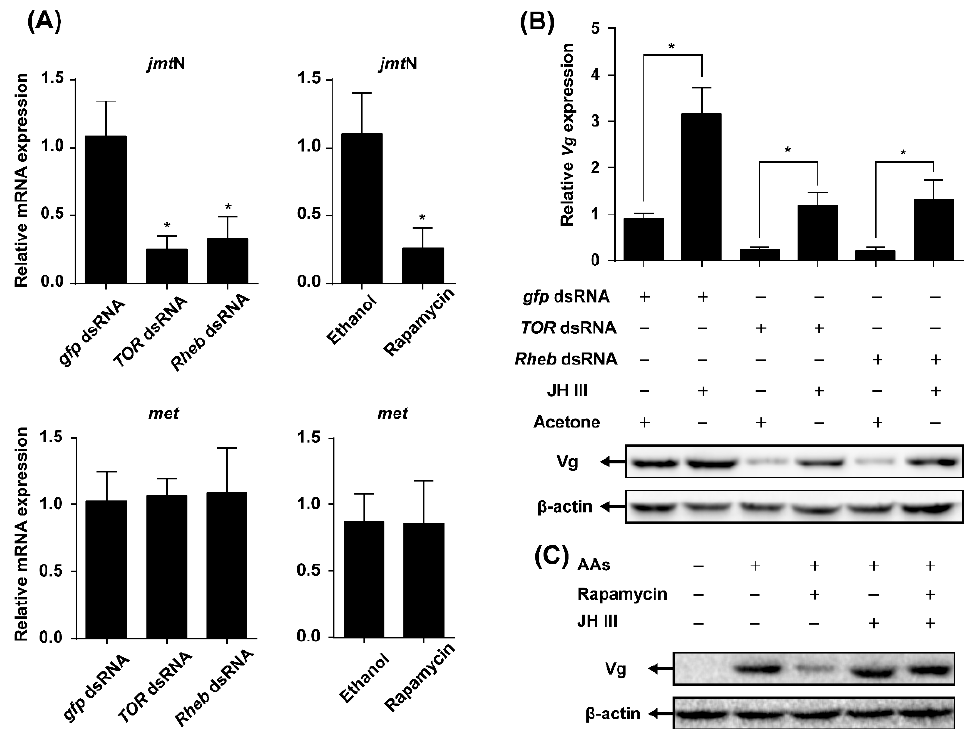
Figure 4. TOR pathway works through juvenile hormone (JH) biosynthesis to regulate Vg synthesis.